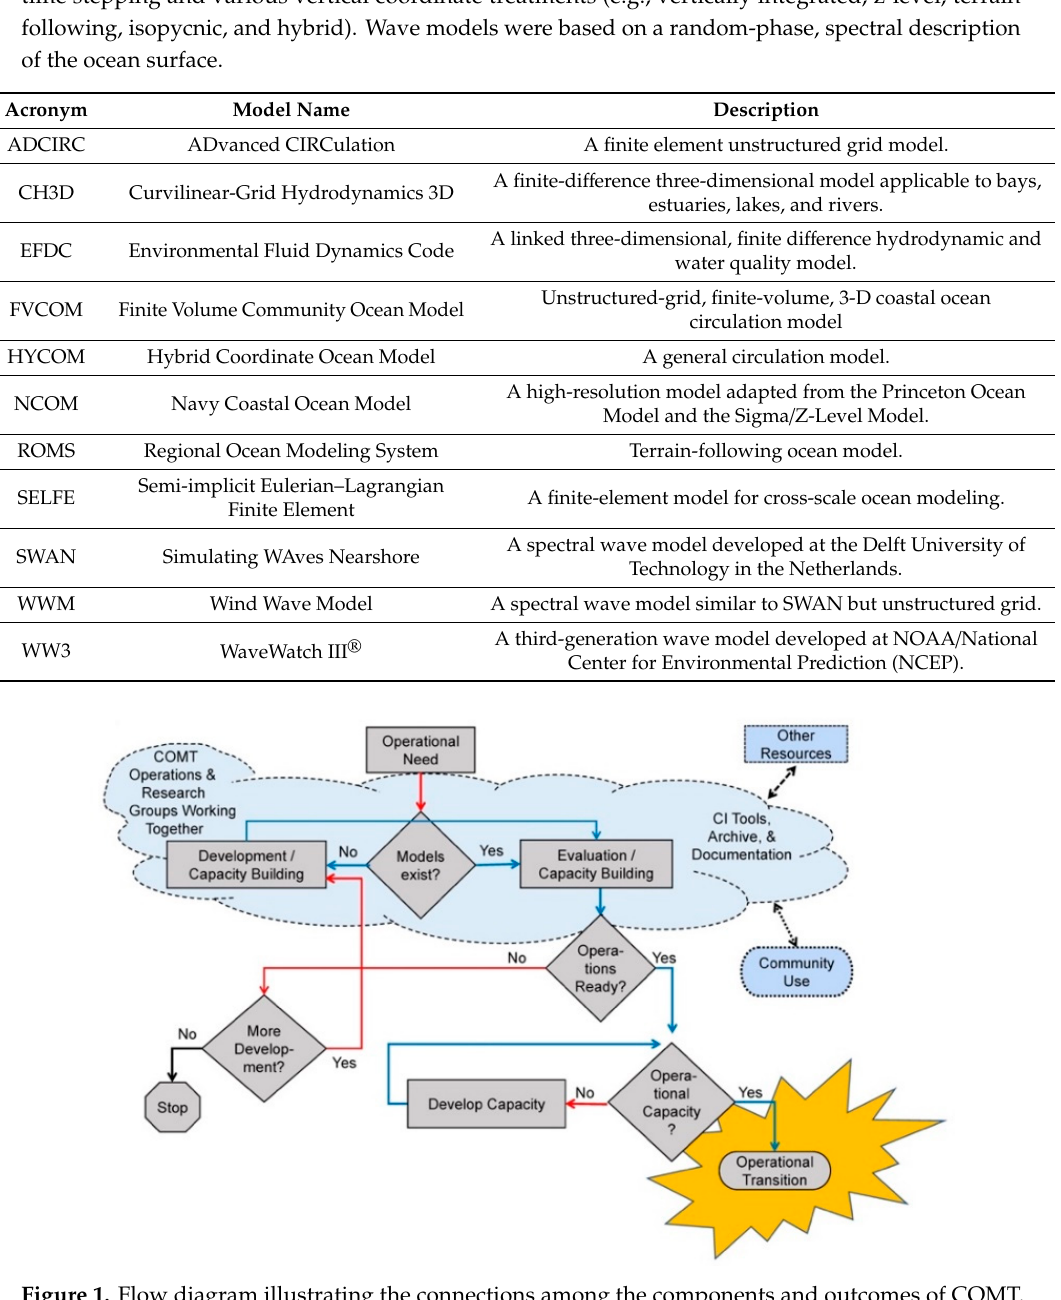
Figure 1. Flow diagram illustrating the connections among the components and outcomes of COMT. Redrawn based on [34] with permission from Journal of Geophysical Research, 2020. The original intent of COMT was to transfer new or improved scientific knowledge or technologies produced by research to operations. The development of transition pathways as COMT progressed were described by [34].